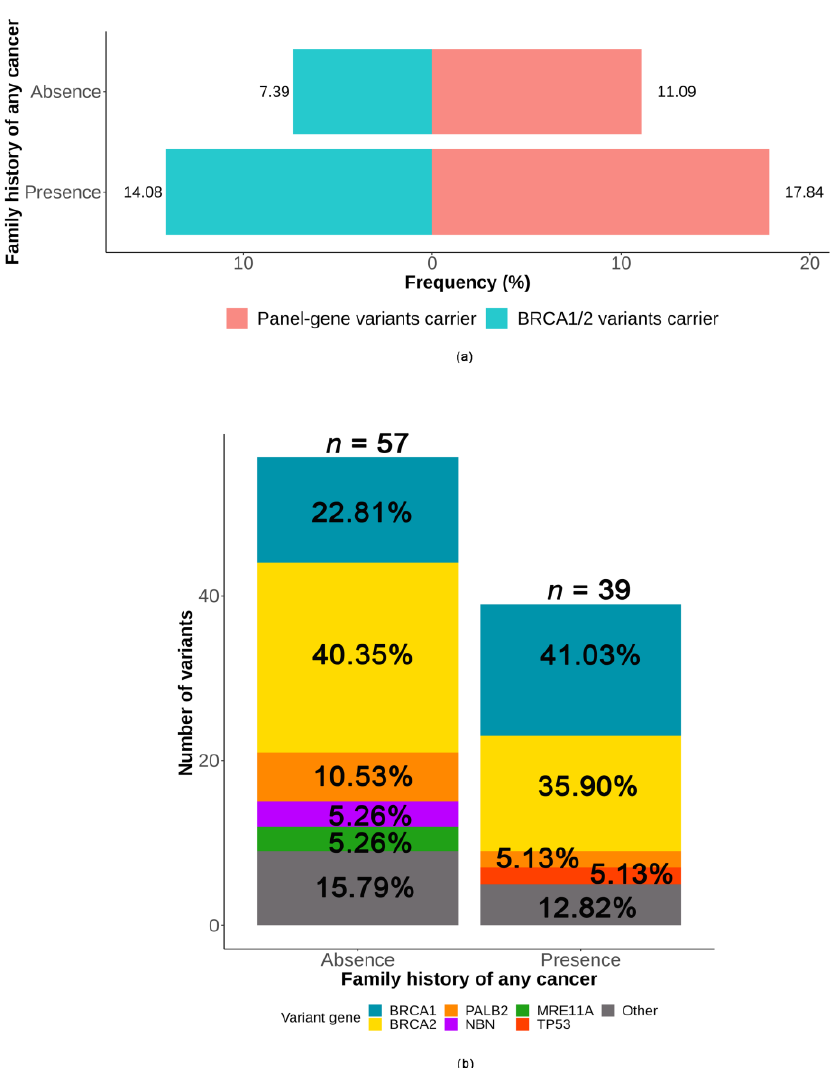
Figure 4. Association between deleterious germline variants and family history of any cancer. ( a ) The variant rates according to family history of any cancer, ( b ) distribution of the variants according to family history of any cancer.